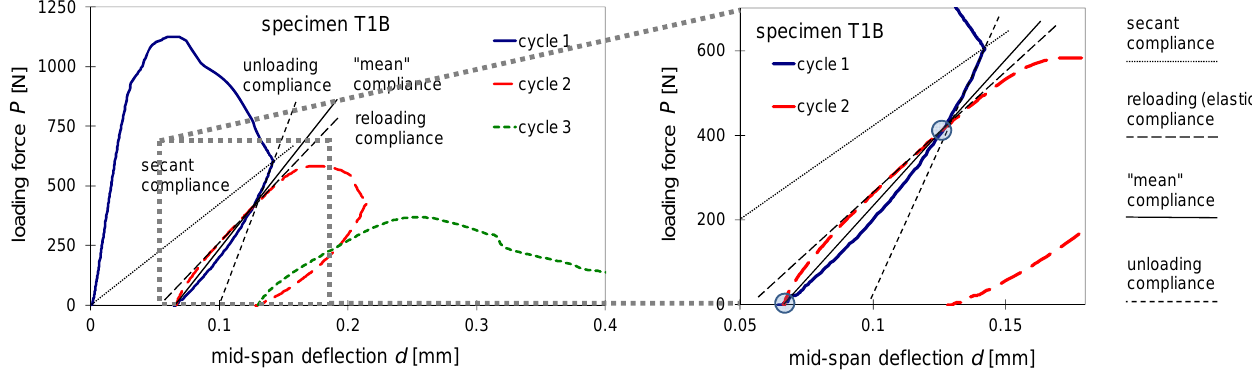
Figure 4: Variants of estimation of the specimen compliances considered for the determination of the effective crack